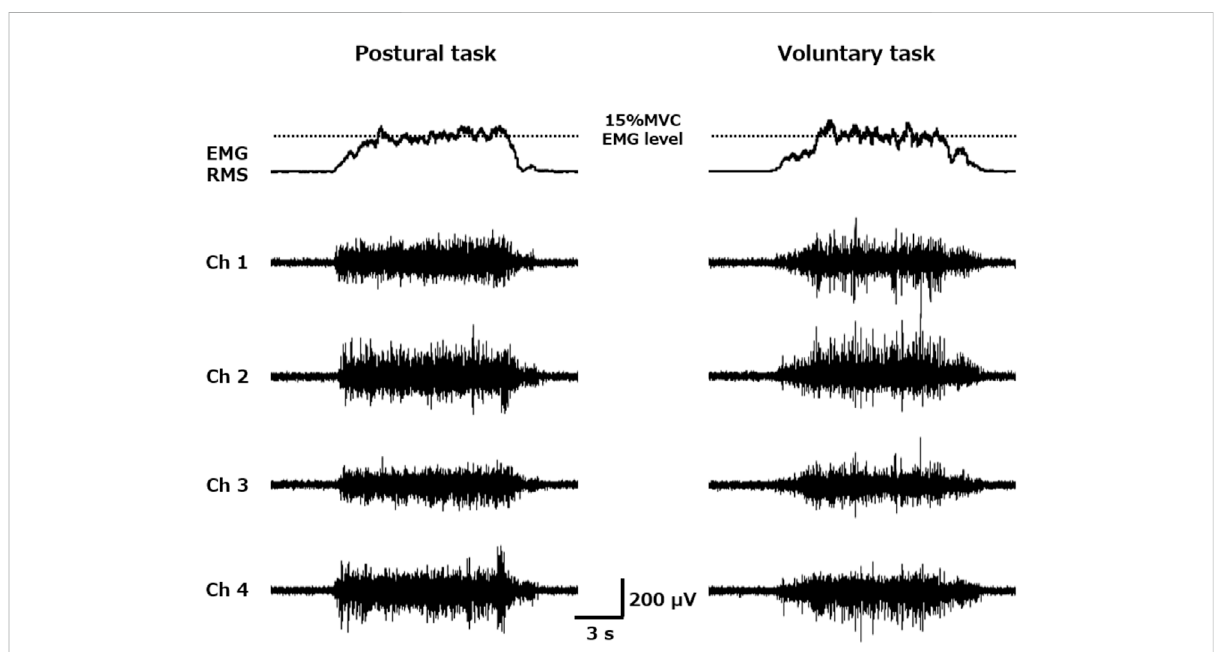
FIGURE 1 Root mean square (RMS) envelope of the electromyography (EMG) activity and four channels of surface EMG raw waveforms obtained during trapezoid muscle contraction. Each participant performed trapezoidal muscle contractions (2.5 s for the ramp-up phase, 8 s for the plateau phase, and 2.5 s for the ramp-down phase) with a target value of 15% maximum voluntary contraction EMG level during both postural (left) and voluntary (right) tasks. The motor unit fi ring properties were extracted from each of the four channels of the surface muscle activity obtained from the vastus lateralis muscle